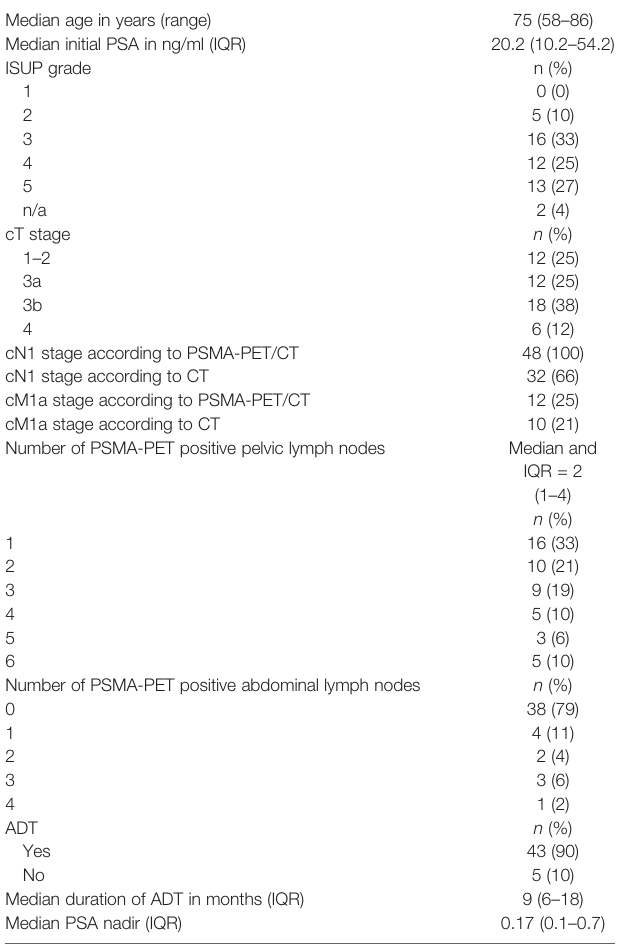
TABLE 1 | Patient characteristics.